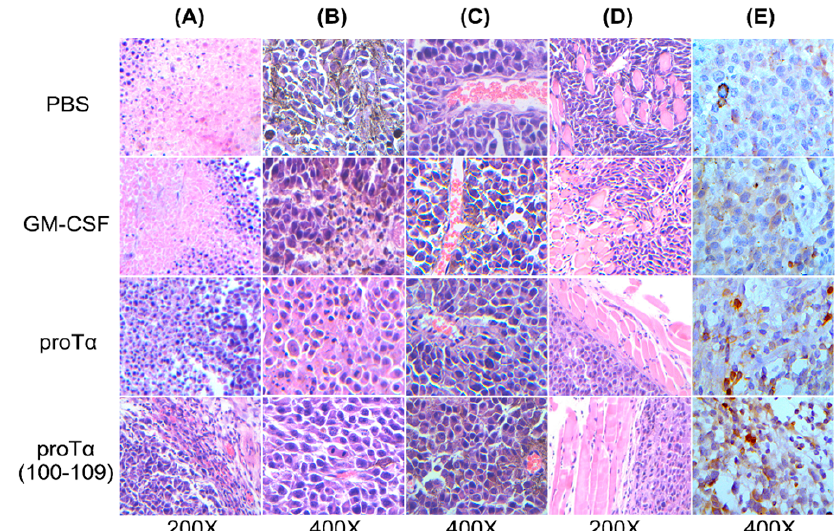
Figure 3. Beneficial modulation of melanoma tumor microenvironment by proT α and proT α (100–109). Sections from para ffi n-embedded tumors harvested from mice ( n = 5 / group) on day 34, were stained with hematoxylin-eosin and microscopically examined for the presence of ( A ) necrosis, ( B ) melanin accumulation, ( C ) vascular invasion, and ( D ) smooth muscle invasion. Sections were also stained with an antibody raised against CD3 ( E ); 200 × and 400 × magnification marked. Representative photographs shown from tumors of mice receiving PBS (control), GM-SCF / AWE, proT α / AWE, and proT α (100–109) / AWE.